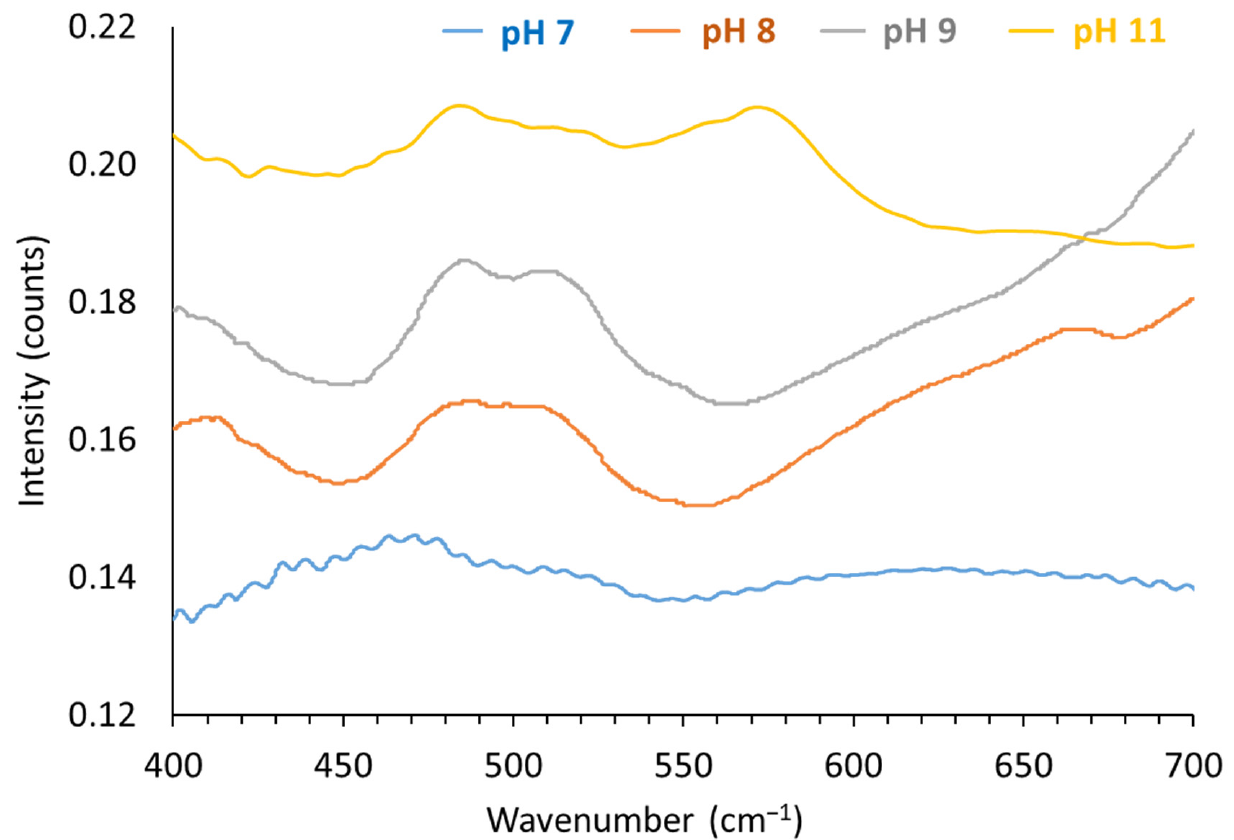
Figure 6. FTIR spectrum of the LDHs synthesized at pH 7, 8, 9 and 11 in the range from 400 to 800 cm − 1 .